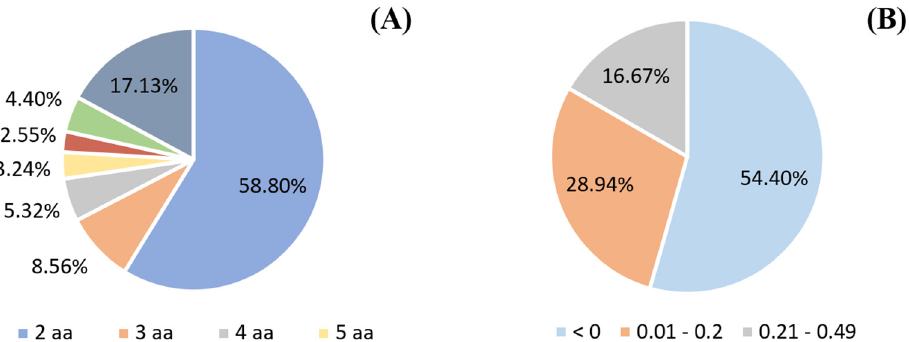
Figure 2. ( A ) DPP-IV inhibitory peptides contained in the bioactive peptides database BIOPEP-UWM grouped according to their amino acid (aa) length. ( B ) DPP-IV inhibitory peptides grouped according to their hydrophobicity, where low values indicate high hydrophobicity and higher values indicate low hydrophobicity. Data obtained from ToxinPred tool.